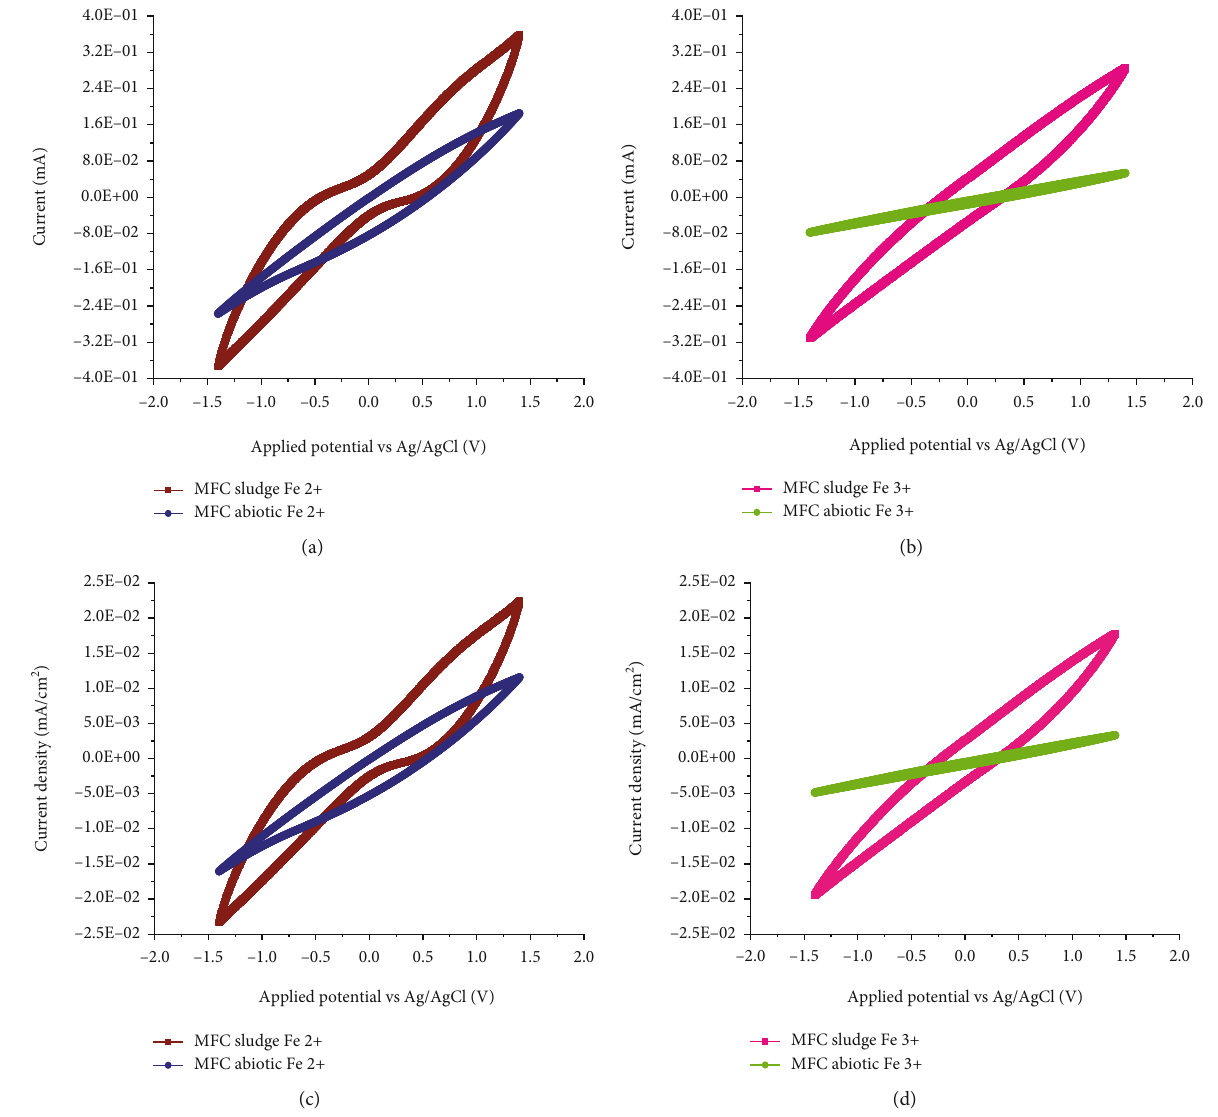
Figure 3: Cyclic voltammetries for the MFCs: (a) comparison of the voltammograms (current) of abiotic MFC and MFC with sludge and Fe 2+ ; (b) comparison of the voltammograms (current) of abiotic MFC and MFC with sludge and Fe 3+ ; (c) comparison of the voltammograms (current density) of the abiotic MFC with the MFC with sludge and Fe 2+ ; (d) comparison of the voltammograms (current density) of the abiotic MFC with the MFC with sludge and Fe 3+